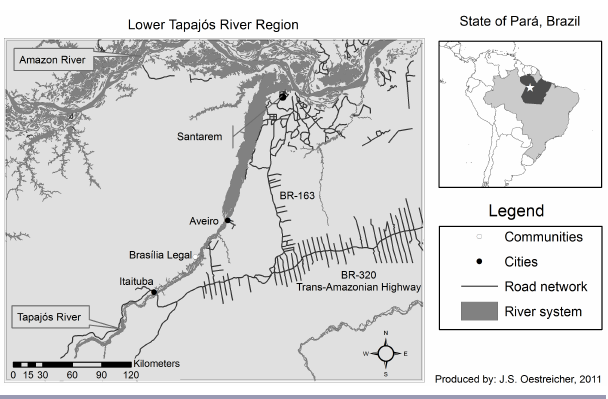
Fig. 1 . Map of the study